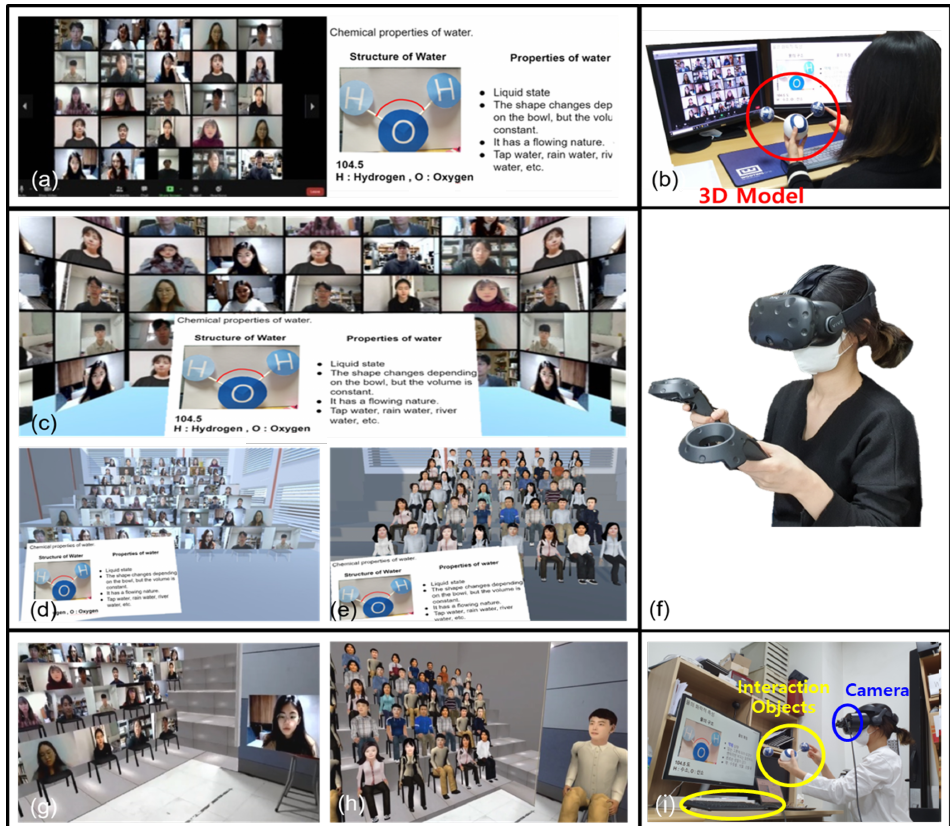
Figure 3. Various platforms for online lecture/performance: ( a ) 2D video teleconference on the ( b ) desktop, ( c ) 2D video grid in VR, ( d ) 3D VR with video screen avatars and ( e ) with 3D full-body avatars ( f ) the use of headset/controller, and AudienceMR with ( g ) video screen avatars and ( h ) 3D full-body avatars; and ( i ) the use of the video see-through